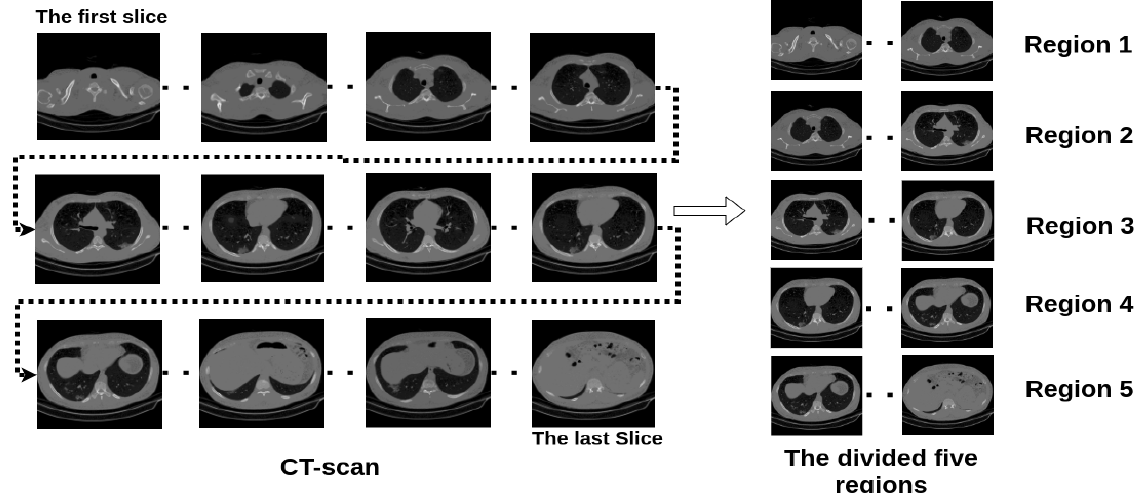
Figure 5. Example of dividing a CT scan into five